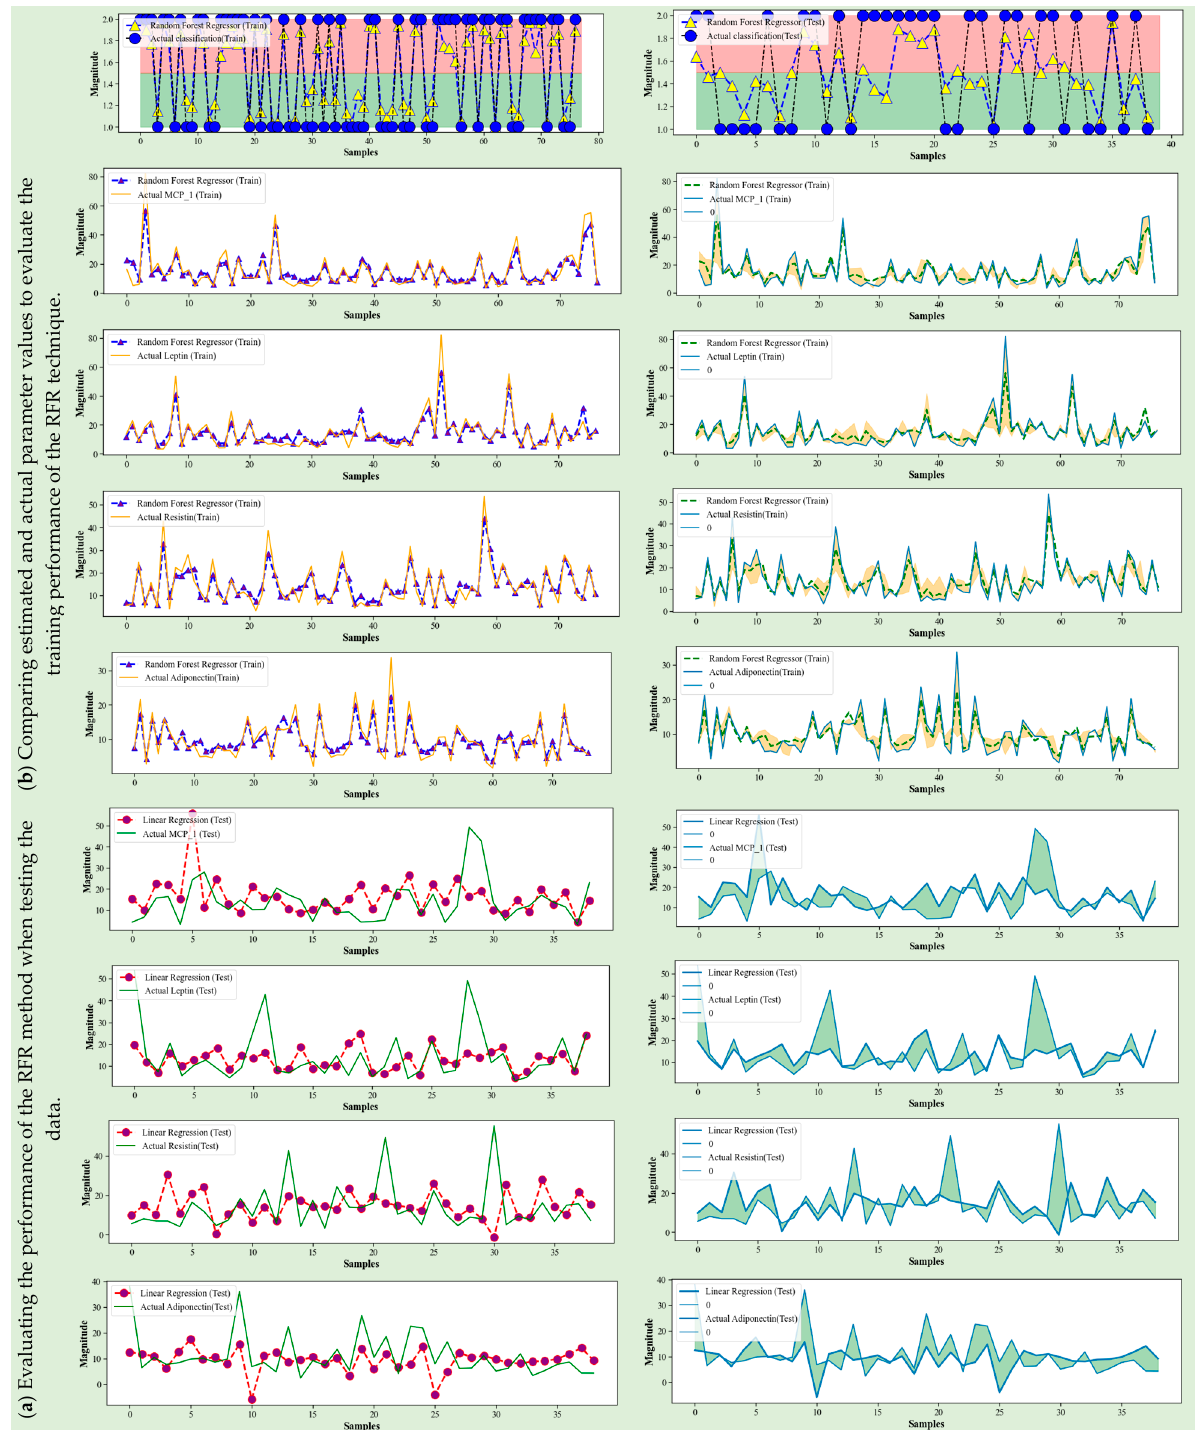
Figure 8. The e ffi ciency of the method in identifying breast cancer by applying it to both training and testing datasets using RFR. The accuracy of the method on the training data is presented in ( a ), while ( b ) demonstrates the evaluation of the technique using the testing data.